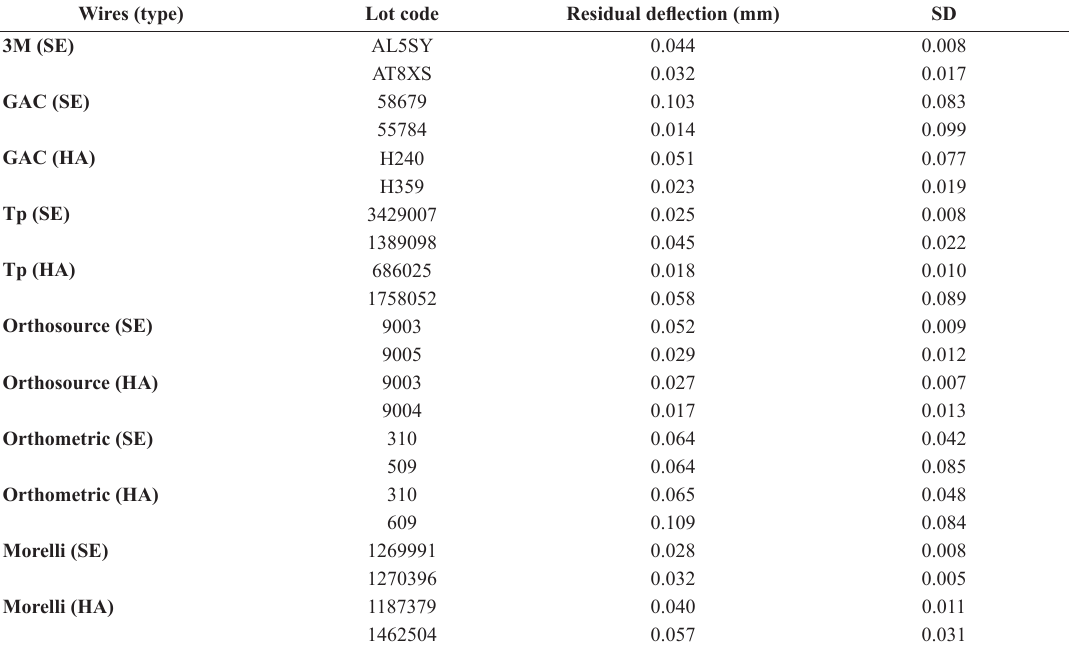
Table 3. Average residual strain (standard deviation - SD) of the superelastic (SE) and heat-activated (HA) NiTi 0.014-in inch orthodontic archwires tested. Wires (type)